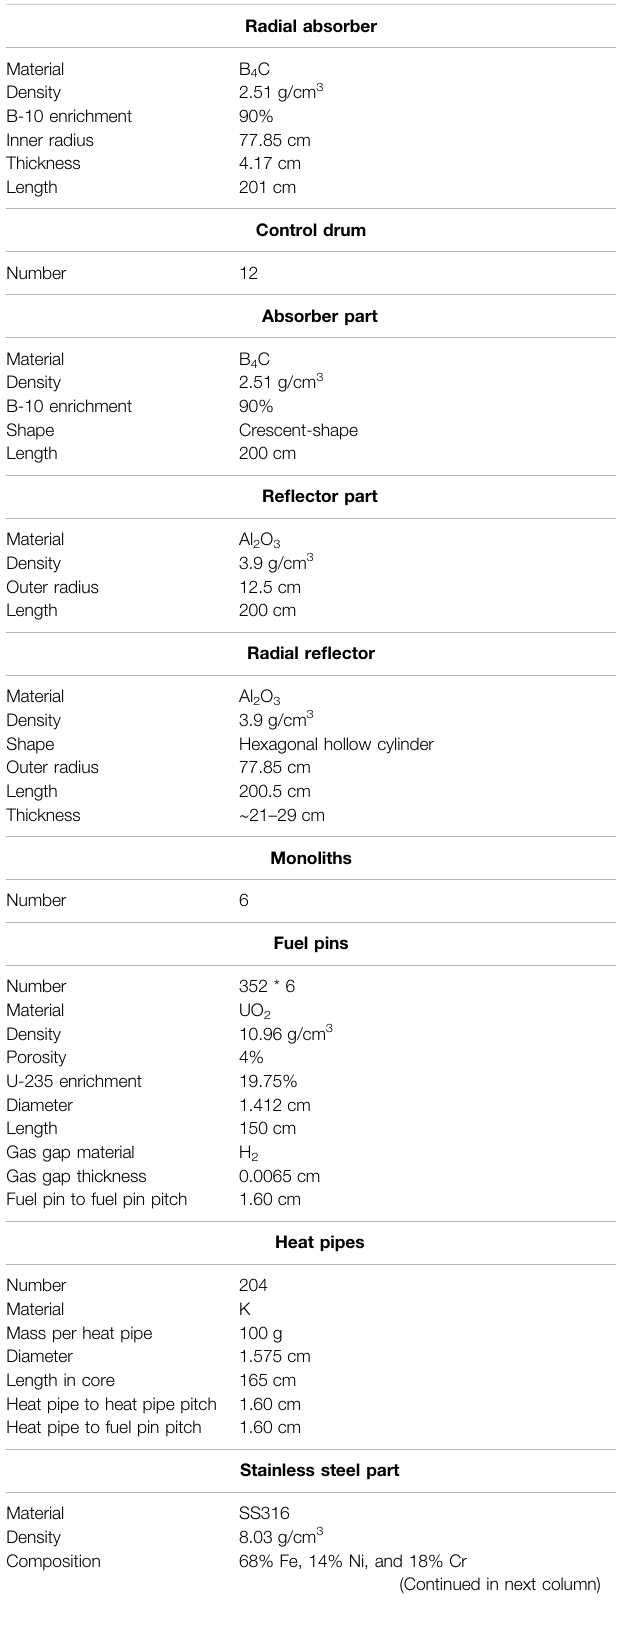
TABLE 1 | Geometric parameters of the LANL design (Sterbentz et al.,